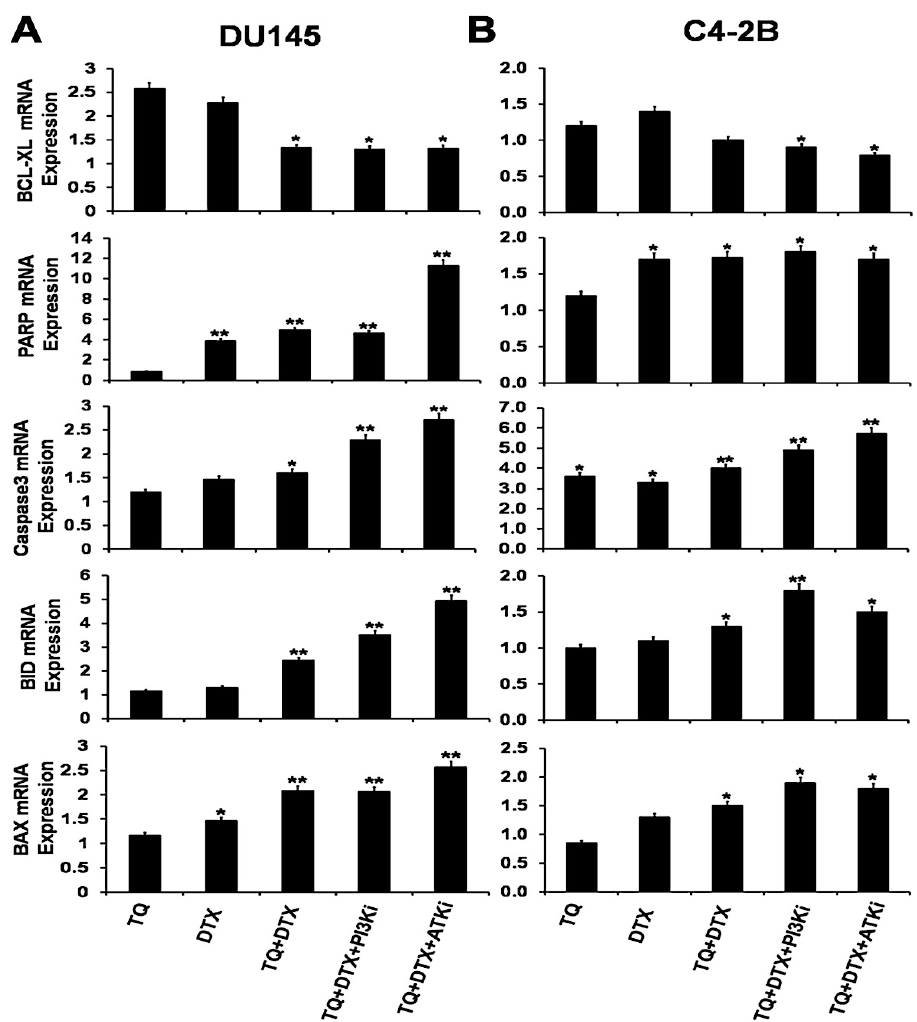
Figure 5. mRNA expression of pro- and anti-apoptotic genes in PCa cells. ( A ) DU145 and ( B ) C4-2B cells were treated with various concentrations of TQ, DTX, or their combination with or without PI3Ki and AKTi for 48 h and quantified by RT-PCR. The expression levels of pro-apoptotic factors (BAX, and BID), PARP, caspase 3, and the anti- apoptotic factor (BCL-XL) are presented as fold changes relative to the control cells. Data were normalized to the levels of expression of the housekeeping gene (18 S), and the experiments were repeated three times. Data are presented as means ± SEM; asterisks indicate significance as determined by Student t -tests. * and ** indicates p value ≤ 0.01 and 0.05, respectively.